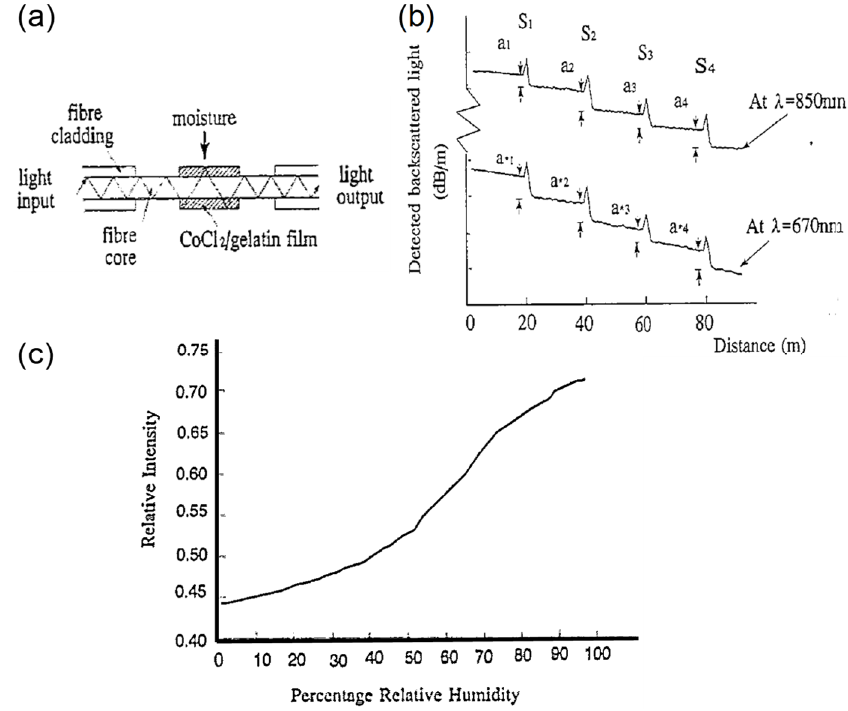
Figure 43. Distributed sensor. ( a ) Conceptual design of each sensing point. ( b ) Example OTDR trace with four sensing points. ( c ) Relative intensity as a function of RH. Adapted with permission from ref. [221]. Copyright 1995 Elsevier